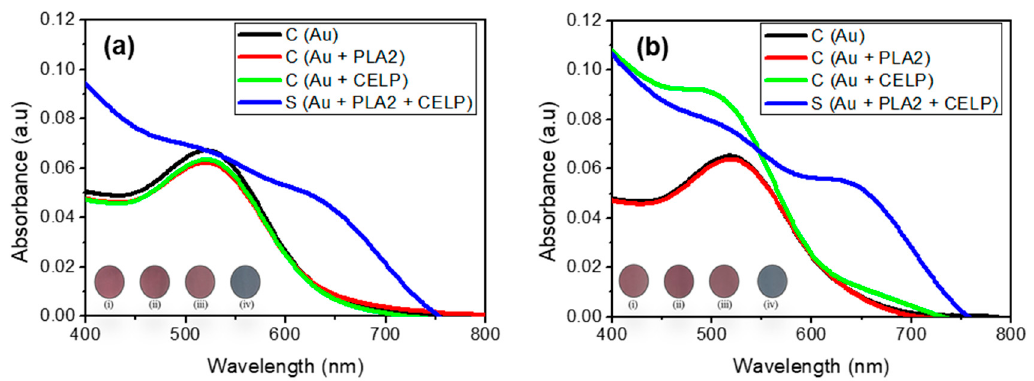
Figure 5. The UV–vis spectra of AuNPs (0.12 mM) under activity of PLA 2 in HPLC water at neutral pH 7.0 ( a ), and phosphate buffered saline (pH 7.4) ( b ). Insets show the corresponding photographs of AuNPs: (i) AuNPs, (ii) AuNPs with PLA 2 , (iii) AuNPs with CELP, (iv) AuNPs with both CELP and PLA 2 .